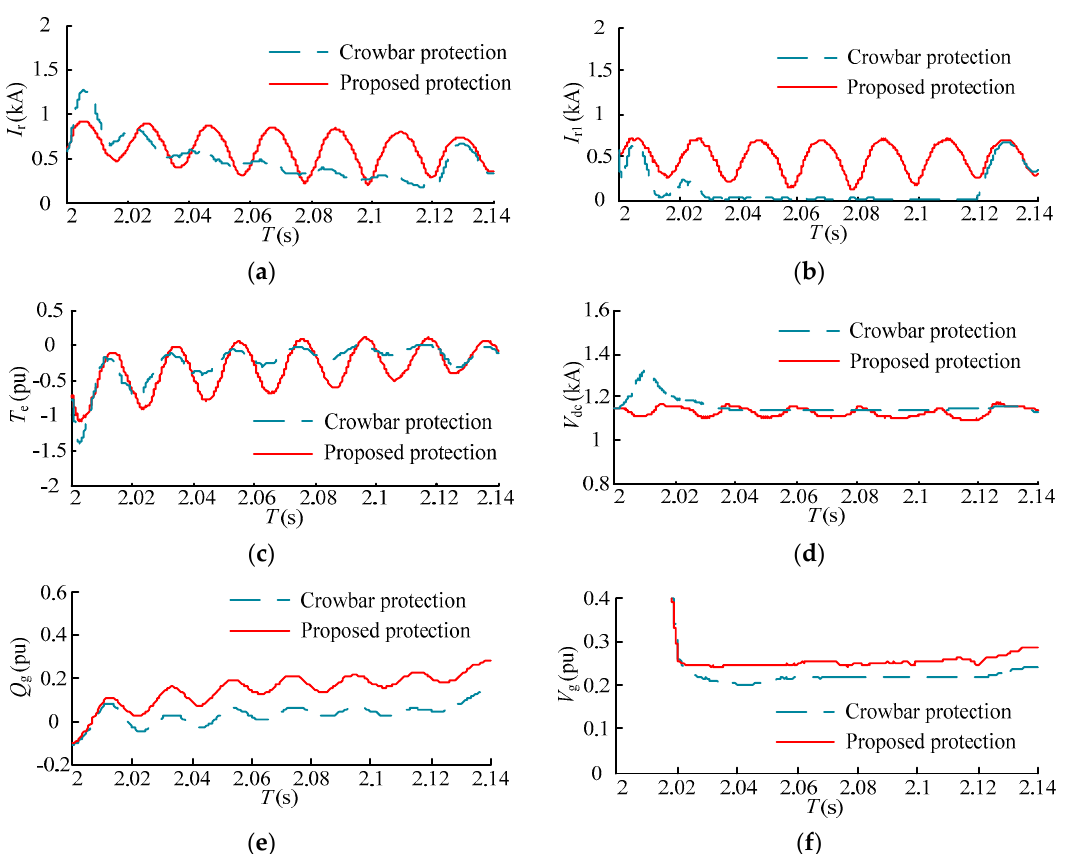
Figure 17. Comparisons between proposed protection and crowbar protection under a voltage sag of 0.8. ( a ) Rotor current; ( b ) RSC current; ( c ) electromagnetic torque; ( d ) DC-link bus voltage; ( e ) reactive power at the grid; and ( f ) the terminal voltage.